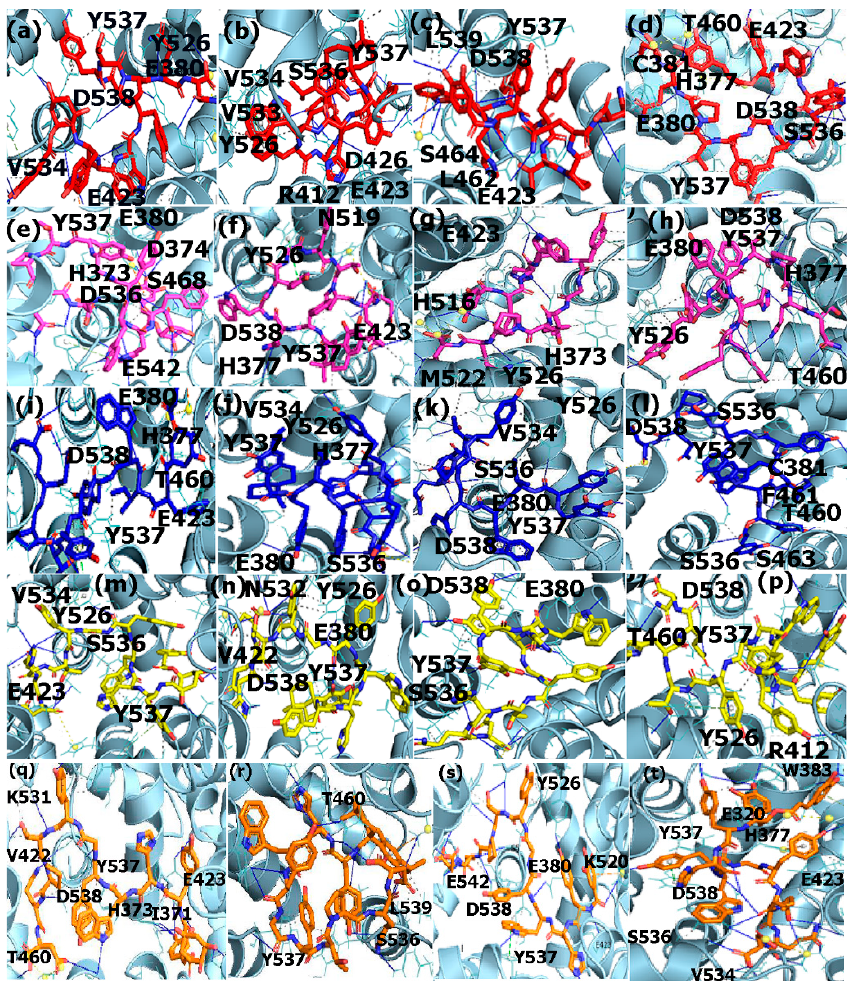
Figure 3. PLIP results for polyphenol peptide conjugates bound to ER α ( a ) CGA-Pep; ( b ) CSA-Pep